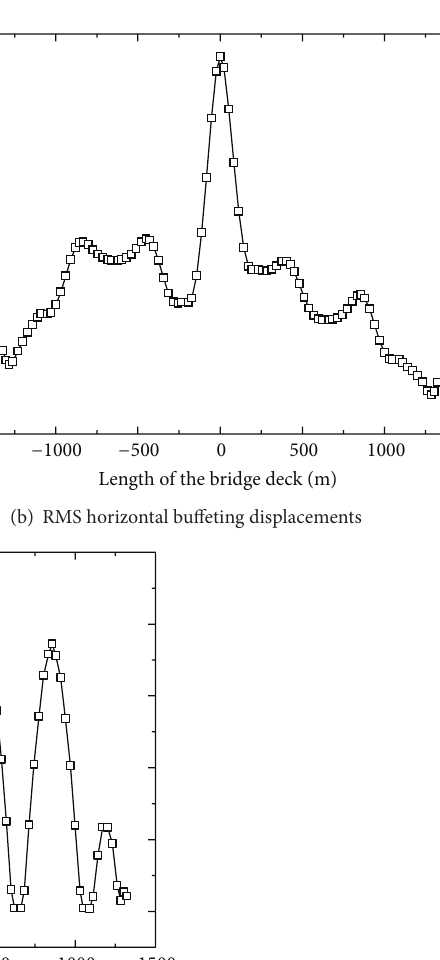
Figure 10: Time histories of buffeting displacements of the 33rd simulation point at the bridge deck.